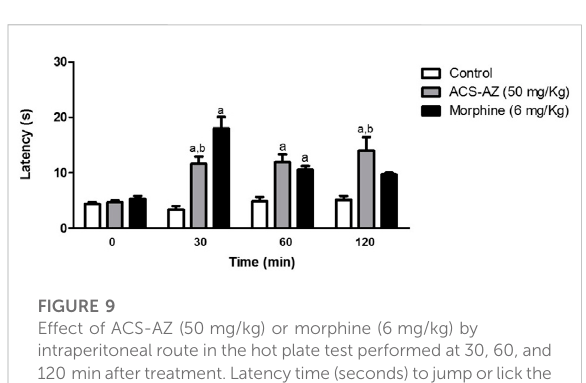
FIGURE 9 Effect of ACS-AZ (50 mg/kg) or morphine (6 mg/kg) by intraperitoneal route in the hot plate test performed at 30, 60, and 120 minaftertreatment.Latencytime(seconds)tojumporlickthe hind paws was recorded for each animal. The results represent the mean ± SEM ( n = 8) analyzed by one-way ANOVA followed by Tukey test: a p < 0.05 vs. control; b p < 0.05 vs. morphine group. ACS-AZ: N ’